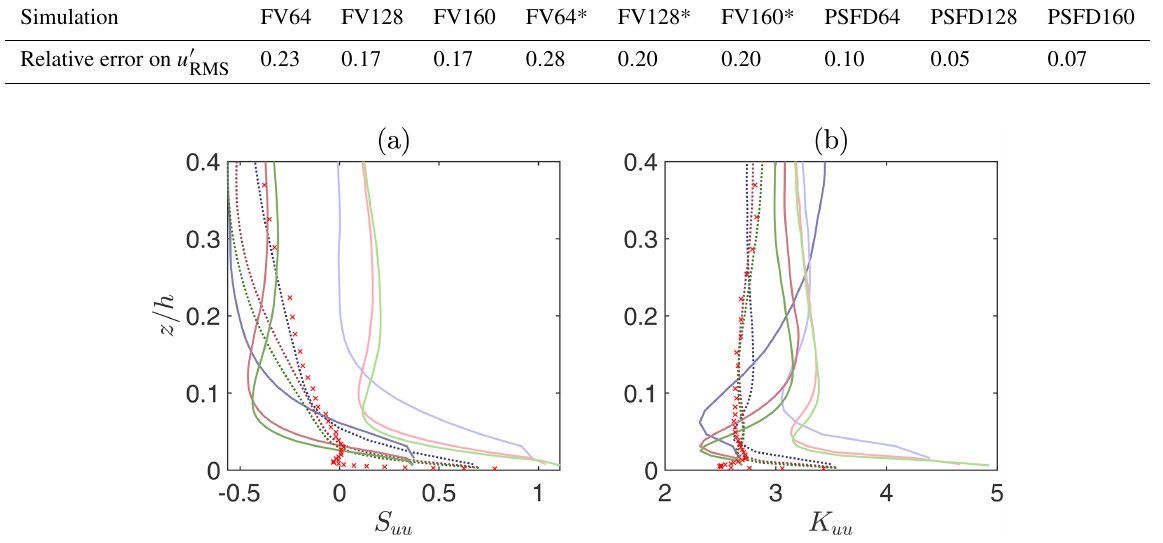
Table 2. Relative error on the turbulence intensities || u (cid:48) (2013) in the interval z 0 /h ≤ z/h ≤ 0 . 4.